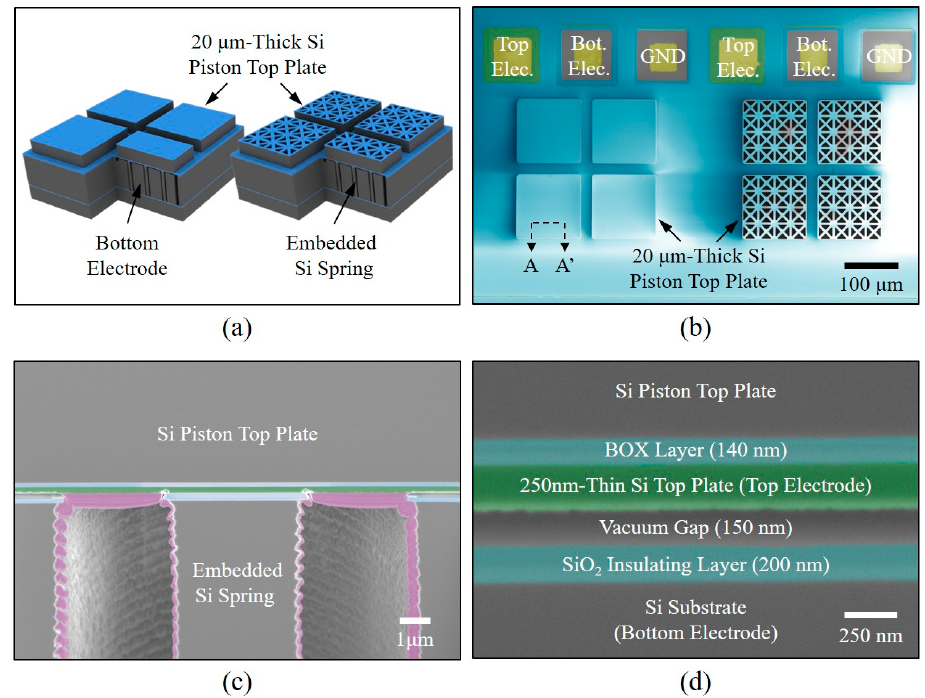
Figure 4. ( a ) A perspective schematic drawing of two different 2D CMUT elements with substrate- embedded springs. ( b ) A top-view colored SEM image of the two different 2D CMUT elements. ( c ) A cross-sectional SEM image of an embedded Si spring bonded with a Si piston top plate (the